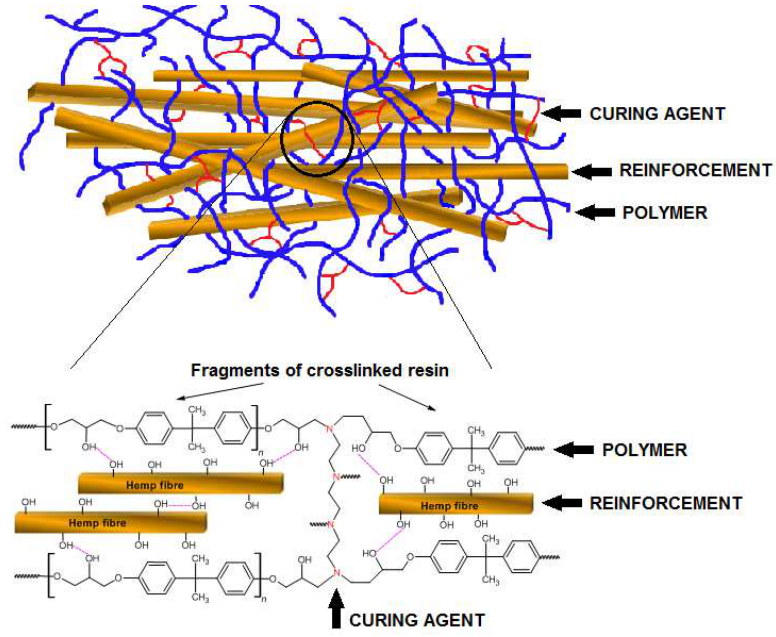
Figure 2. Simplified structure and interactions between components in the polymer composite with eco-filler.